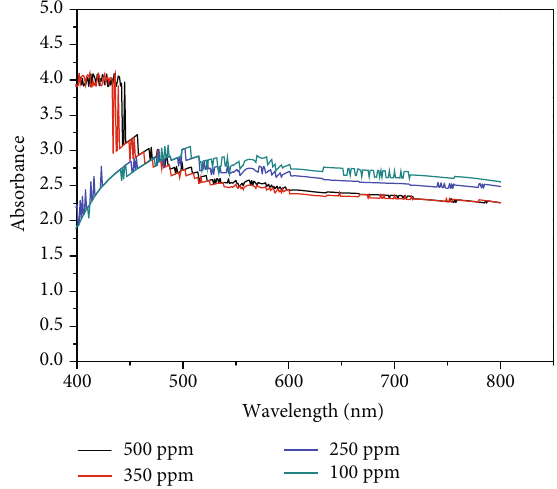
Figure 9: Absorbance of Therminol 55-TiO